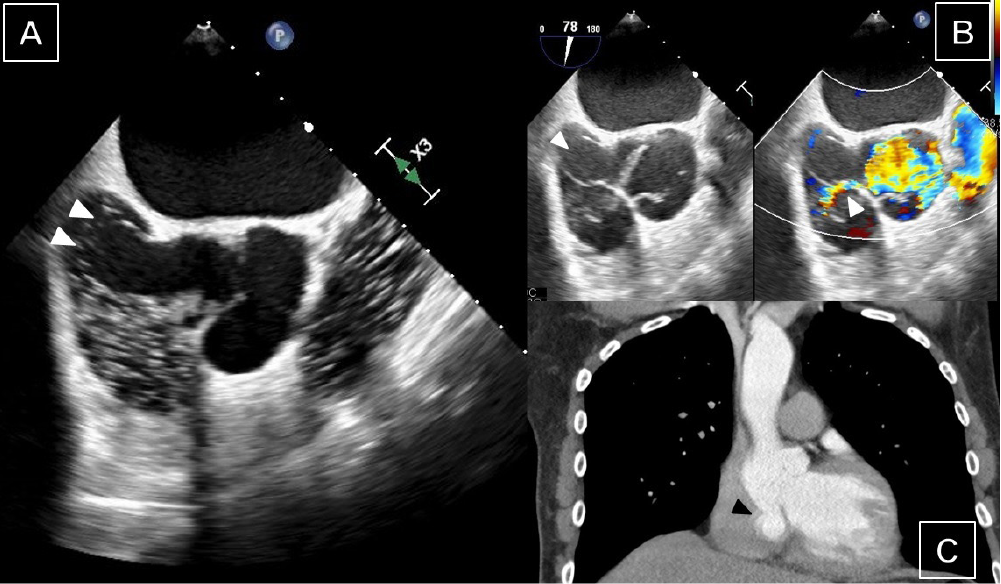
Fig. 1 - Preoperative transesophageal echocardiography (A, B) and contrast-enhanced computed tomography imaging (C) showing the sinus of Valsalva aneurysm with an aorto-right atrial shunt (arrows).